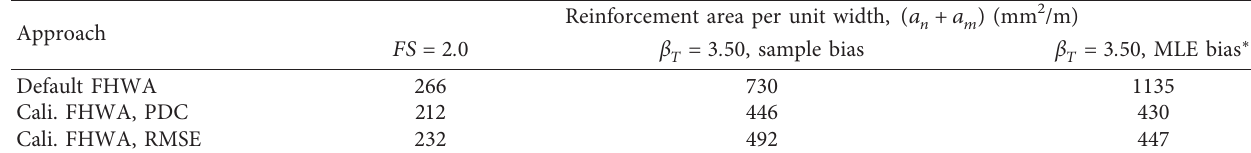
Table 6: Comparisons of reinforcement area per unit width for facing design against flexural failures using default and calibrated FHWA simplified facing load